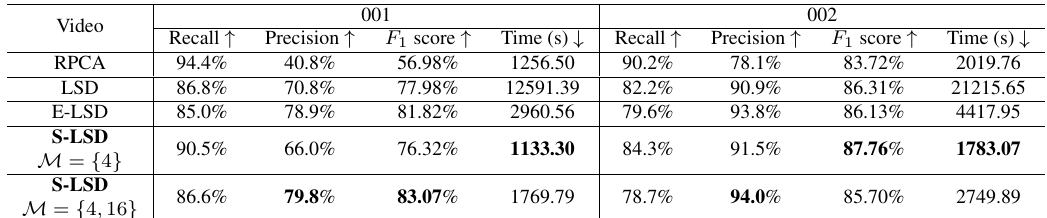
Table 3. Detection Performance